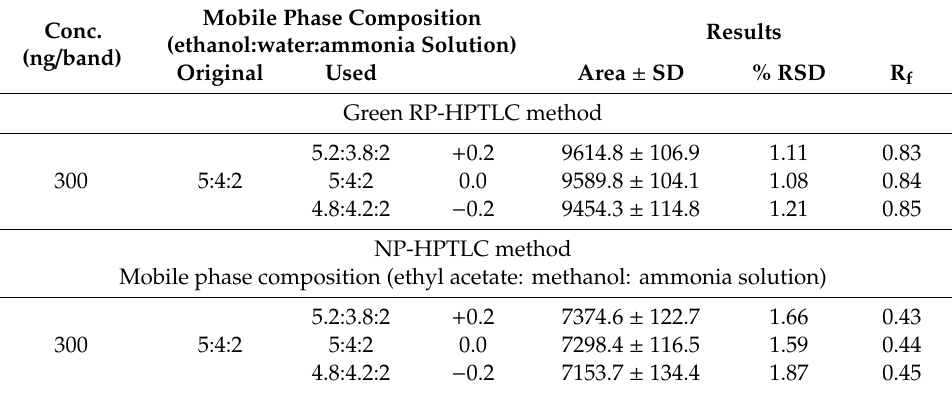
Table 5. Robustness data for green the RP-HPTLC and NP-HPTLC methods ( n = 6).